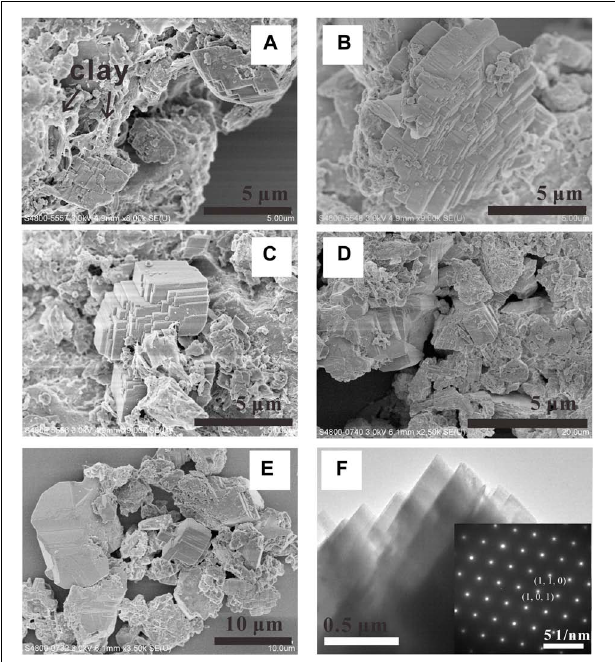
FIGURE 8 | SEM observations (A–E) of magnesite formed in the [H 2 O-CO 2 ]-komatiite system. (F) TEM image of magnesite crystal and the related SAED pattern.